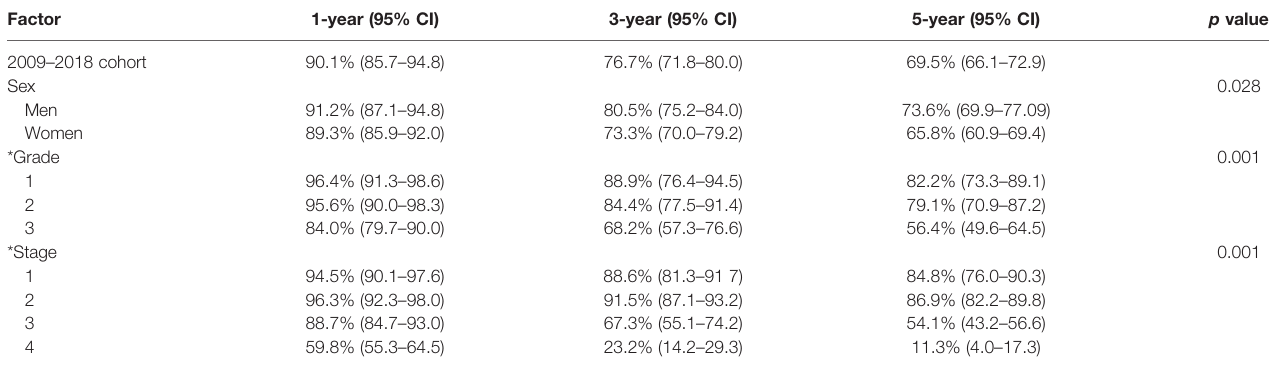
TABLE 3B | Overall survival by prognostic factors in 2009 –